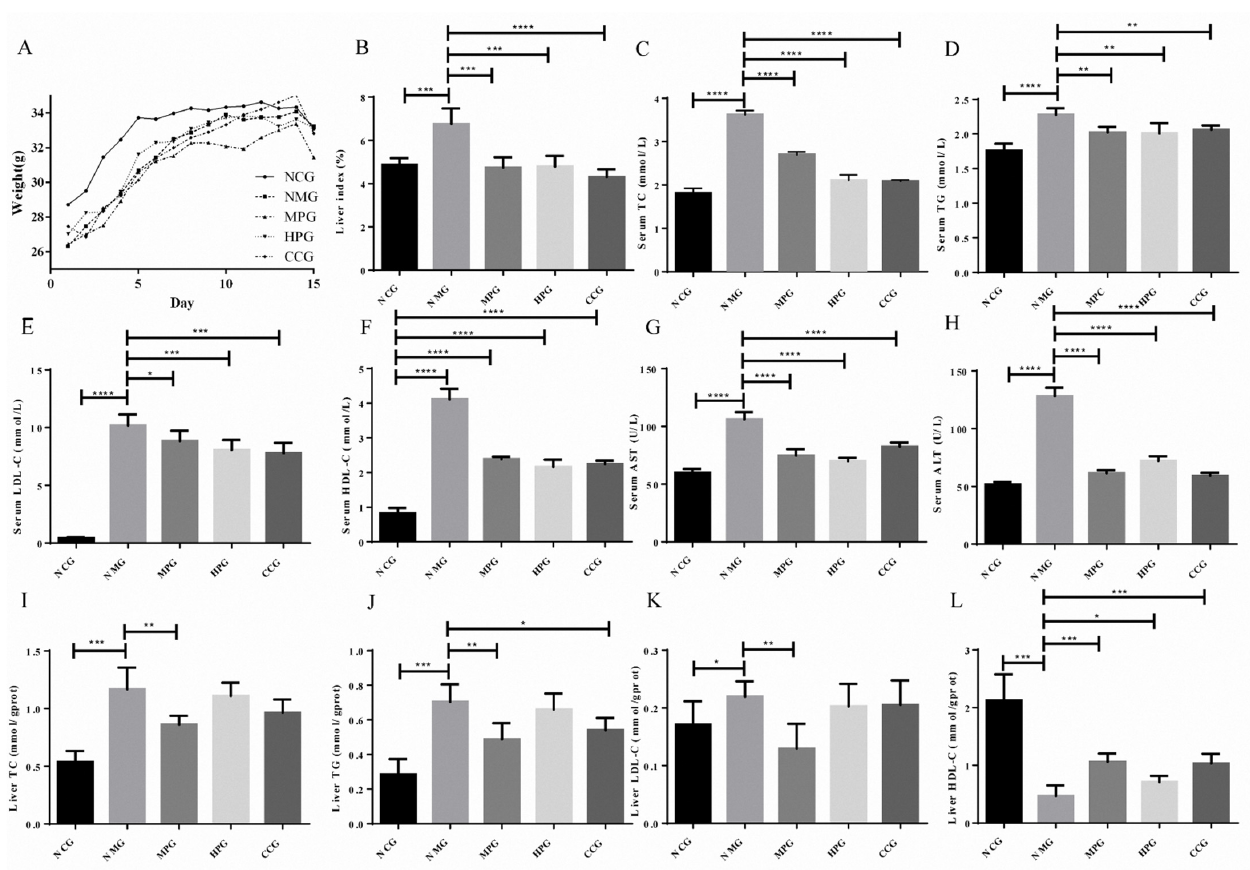
Figure 4. ( A ) the body weight of the mice; ( B ) liver index of the mice; ( C ) serum TC index results; ( D ) serum TG